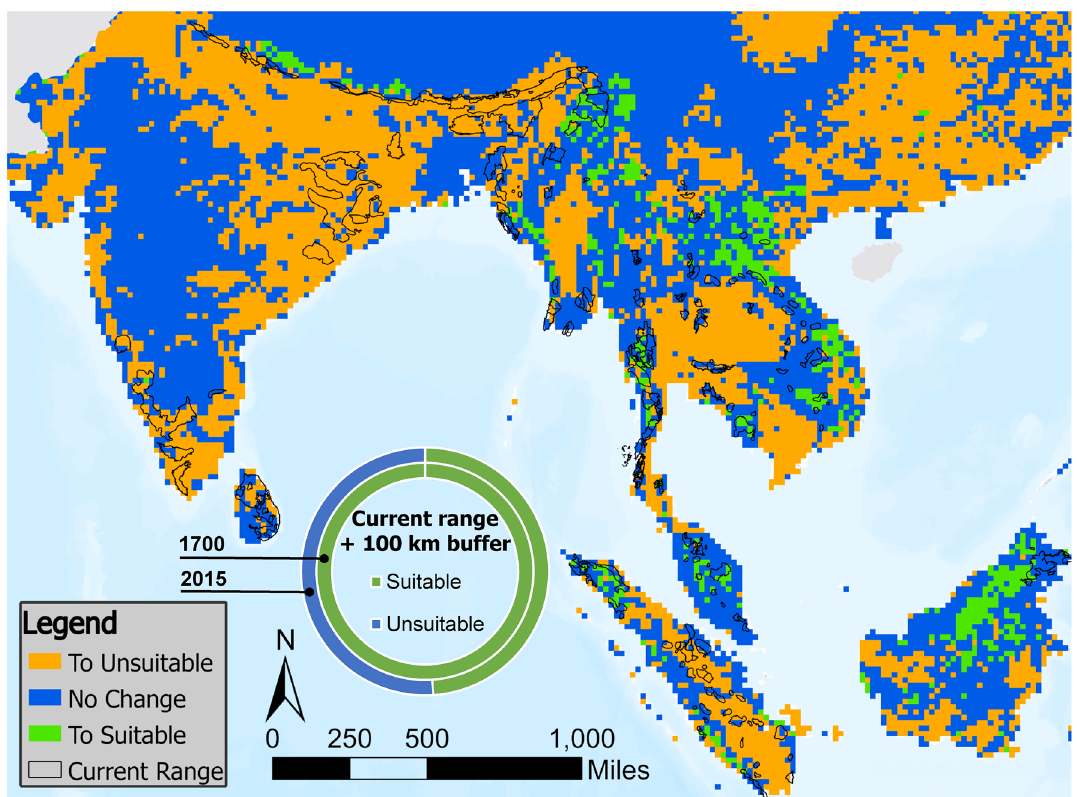
Figure 3. Loss and gain in suitable habitat across the range between 1700 and 2015. Masked areas (Pakistan, Hainan Island) have been excluded from analysis. Overall, 64.2% of the total area converted from suitable to unsuitable in this period, with 38.6% occurring within the current range (Table 3). Habitat gains largely occurred outside the current range. Donut chart shows that 100% of area within 100 km of the extant range was classified as suitable in the year 1700, but dropped to 48.94% by 2015 (see Figure S3 for